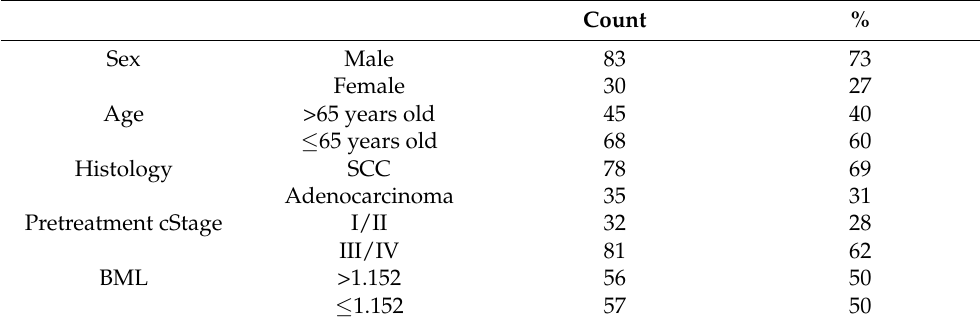
Table 1. Baseline characteristics of the cohort study. Data are presented as absolute count and per-